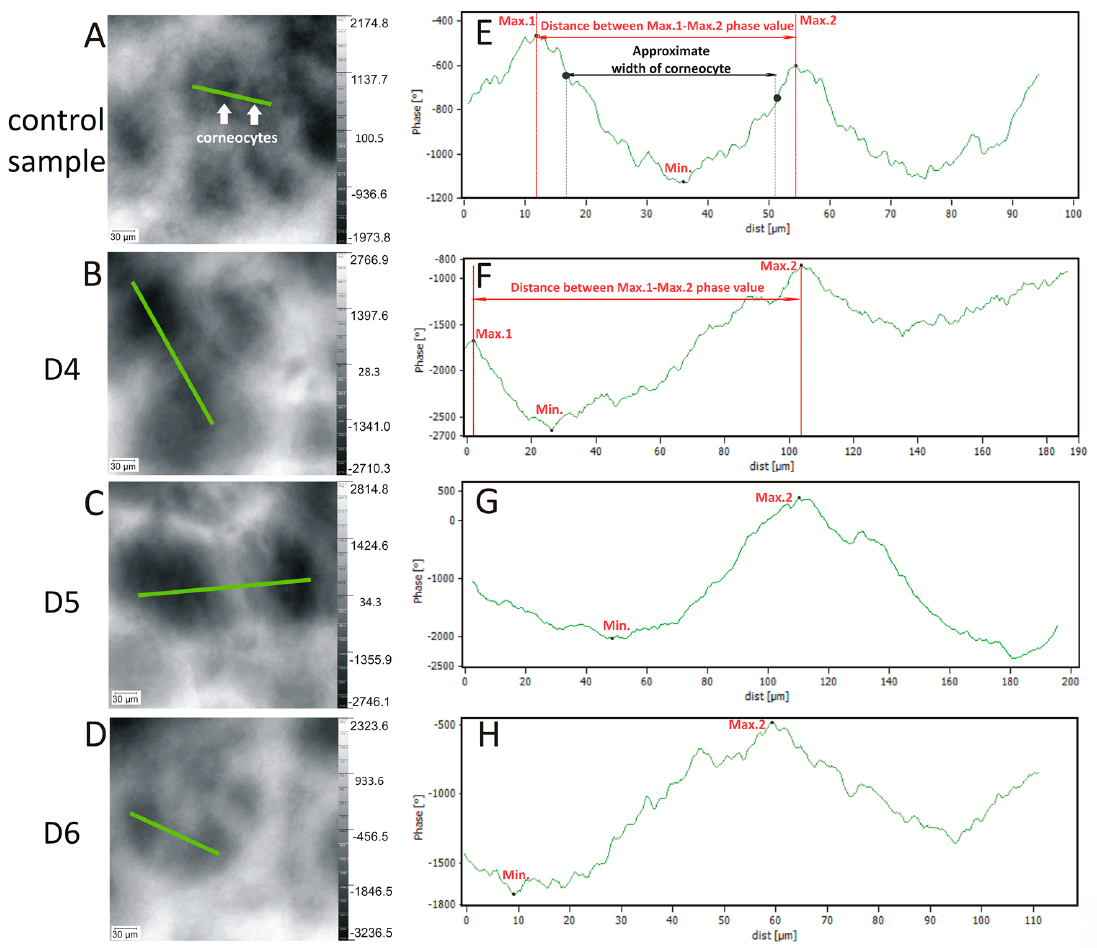
Figure 2. Holographic images (unwrapped phase image) and corresponding profile lines of the differences in phase along the green lines in ( A – D ), when the human stratum corneum structure is changed under the influence of cyclic siloxanes compared with the control sample, where the control sample ( E ) and test samples ( F – H ); the magnification 20 × . The values of the phase are determined with reference to the mean value in the respective image.